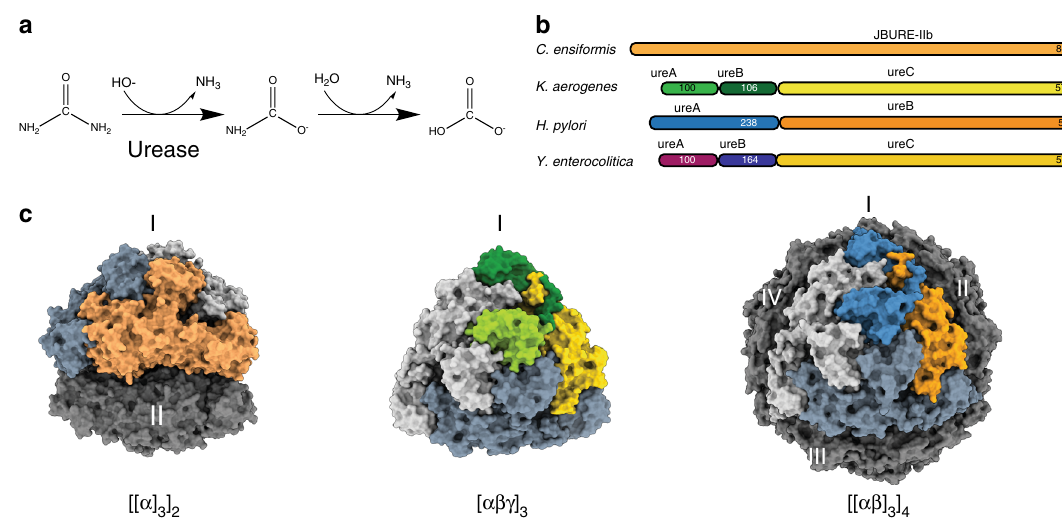
Fig. 1 Protein architectures and oligomeric assemblies of ureases. a Schematic of biochemical reaction catalyzed by urease. b Protein architecture of urease functional unit from full length C. ensiformis (Jack bean urease) 58 , K. aerogenes, H. pylori , and Y. enterocolitica . c Surface representation of oligomeric assembly of urease in C. ensiformis (PDB: 3LA4), K. aerogenes (PDB: 1EJW) , H. pylori (PDB: 1E9Z), respectively. Proteins are color-coded as in b . Oligomeric state of urease assembly is indicated at the bottom and the trimeric assemblies are indicated in roman